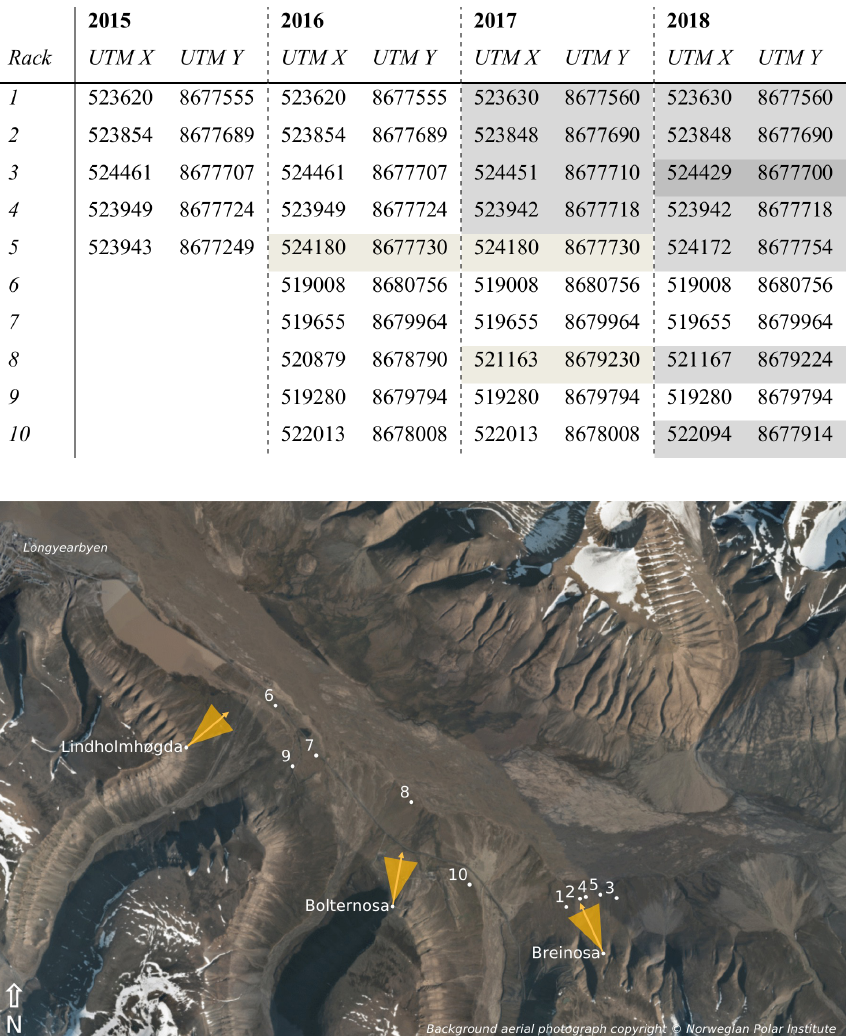
Table 1. Location of the camera racks from 2015 to 2018. Two racks were relocated to a different vegetation type (rack 5 in 2016 and rack 8 in 2017). In 2017 and 2018, adjustments were made to the base of the racks, and many were moved a few metres within the same vegetation type. A change in the shading indicates that the rack was moved.